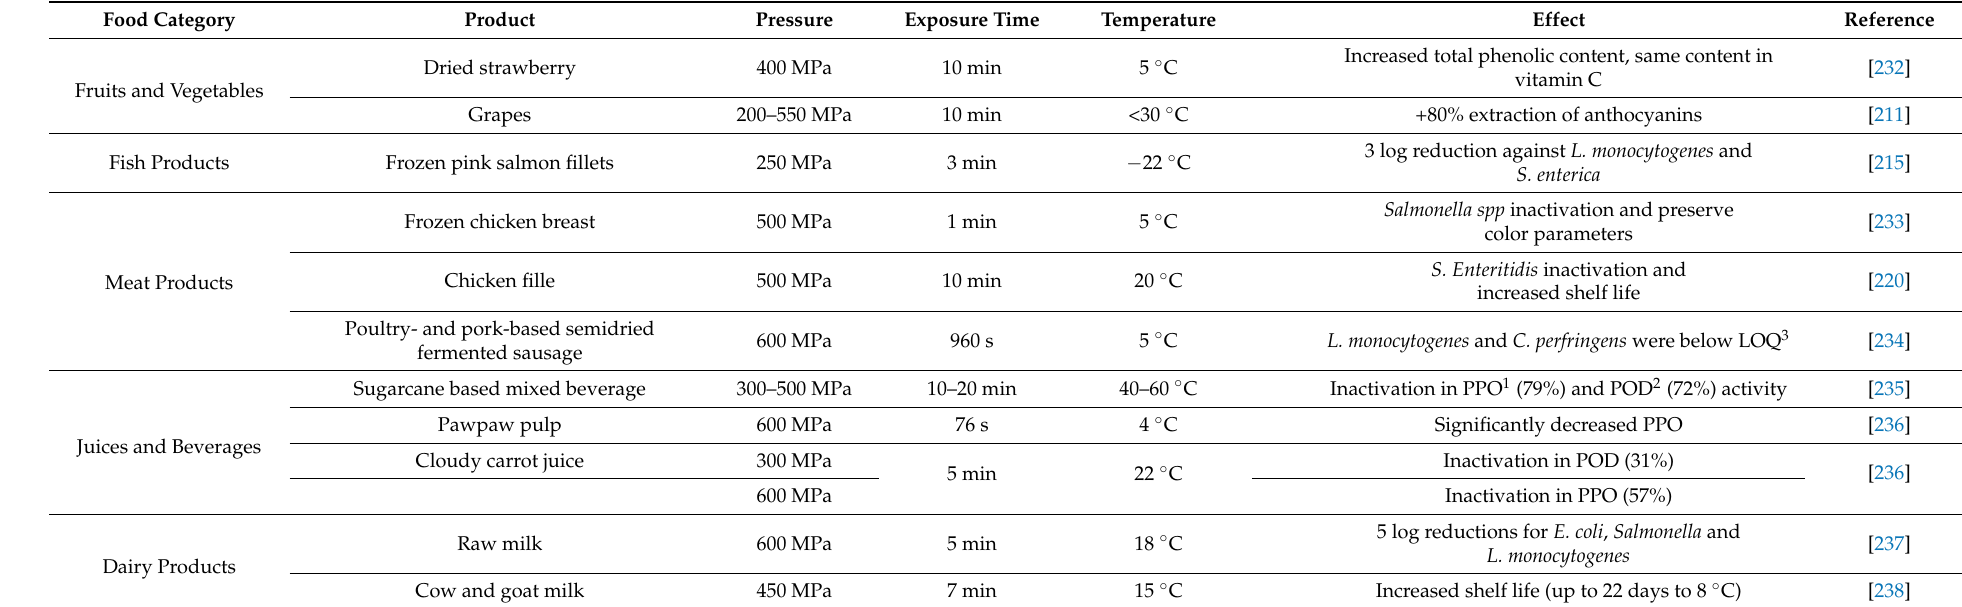
Table 5. Recent studies of applications of high-pressure processing in different food